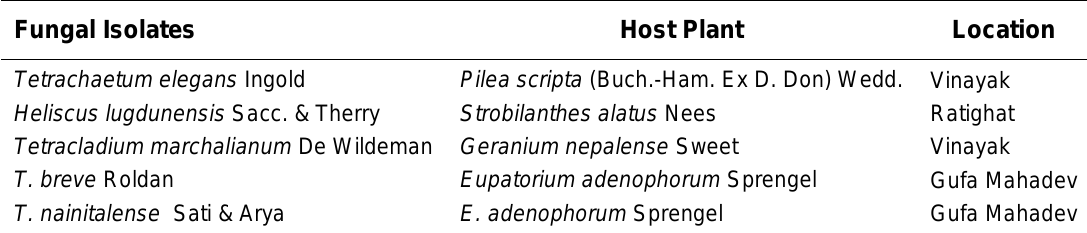
Fungal Isolates, Their Host, and Location at Nainital, India Fungal Isolates Host Plant Location Tetrachaetum elegans